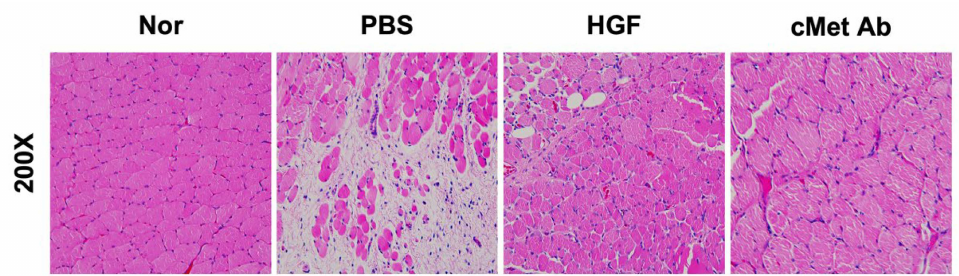
Figure 1. Representative histological images of H&E staining of specimens from the normal, PBS, HGF, and c-Met groups at three weeks post-injury (original magnification: 200 × ).